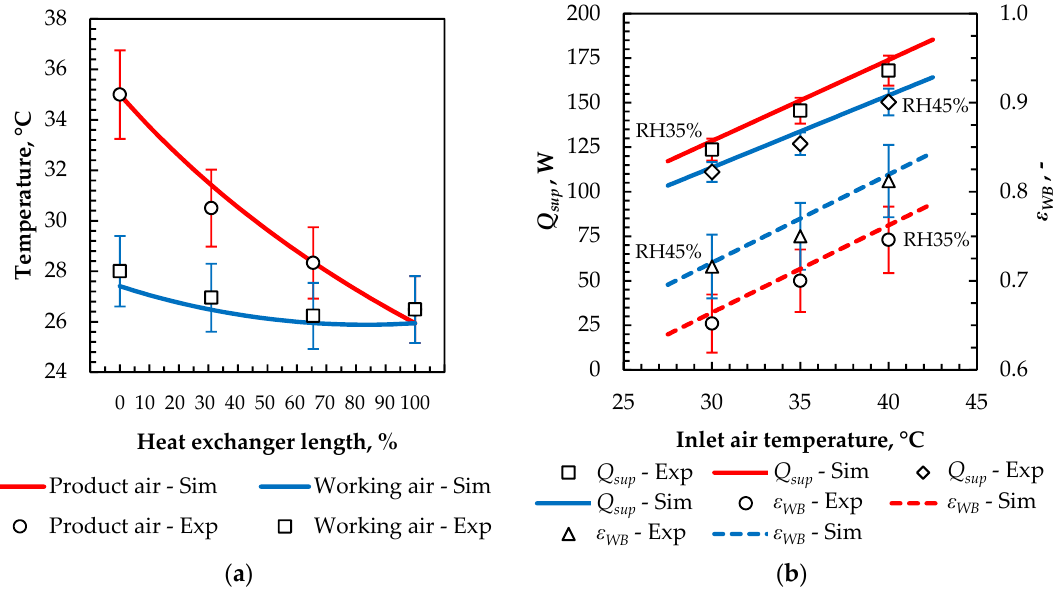
Figure 5. Comparison of the simulation output with the experimental data for a heat pipe and porous ceramic-based sub wet-bulb temperature evaporative cooler (IEC1) (Appendix D [43]): ( a ) Product and working air temperature distribution for inlet conditions 35 °C and RH 35%; ( b ) Impact of inlet air temperature on the cooling capacity and wet bulb effectiveness.